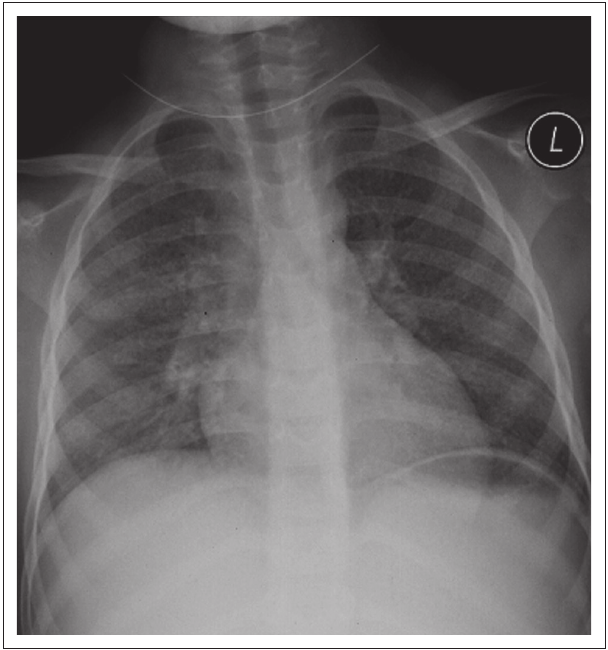
FIGURE 3: Multidrug-resistant tuberculosis in a 6-year-old girl. Frontal chest radiograph demonstrating diffuse miliary opacification. There is enlargement of the hilar regions bilaterally suggestive of associated hilar